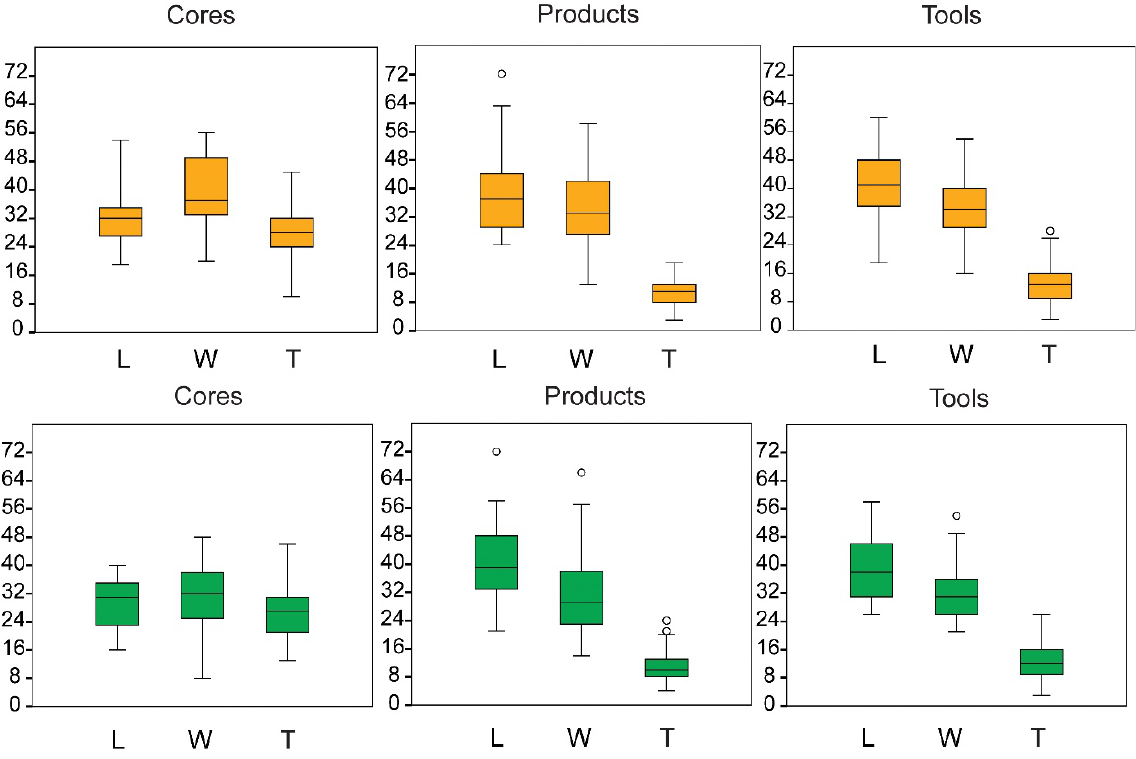
Figure 5. Morphometric analysis for length (L), width (W) and thickness (T) of cores, products and tools (Middle Neolithic in yellow, Late Neolithic in green; all measurements presented in